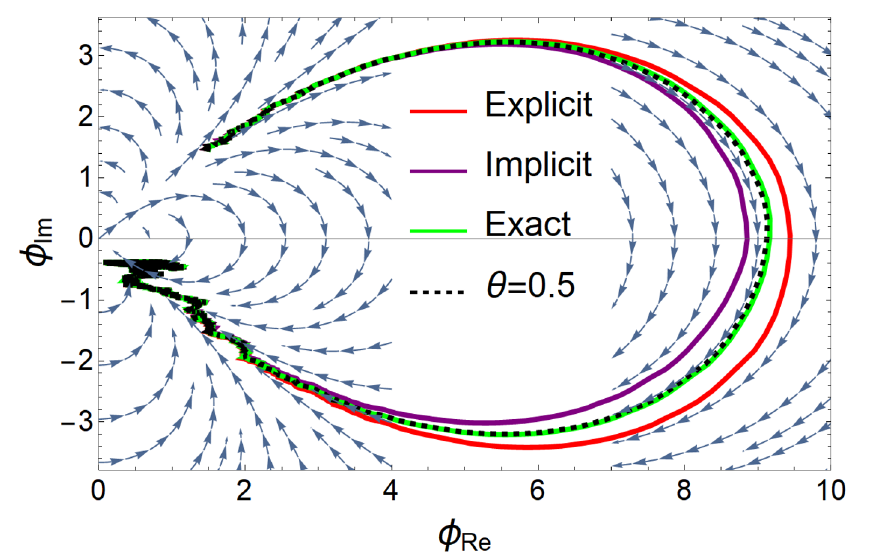
Figure 1 . Example of complex Langevin paths for a single degree of freedom in the potential V ( φ ) = iφ 4 based on different solvers: (red) explicit EM, (violet) implicit EM, (dashed) unitary θ = 1 / 2 EM and the exact solution given as green line. Each path is initiated at (1 . 5 , 1 . 47) close to the divergent flow line. The Langevin time step size is kept constant at ∆ τ L = 10 − 4 . Note the characteristic over and undershooting of the explicit and implicit method